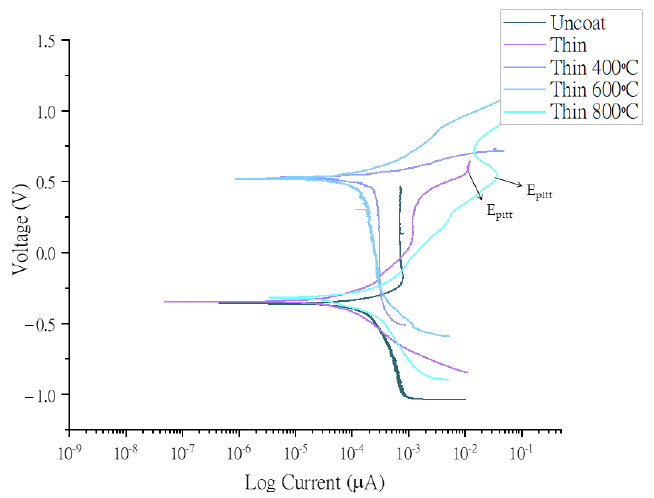
Figure 5. Polarization curves of Co30Cr20Ni20Mo20Ti10 alloy versus Ag/AgCl electrode in Hank’s solution. Working electrode was deposited at 2 × 105 ion density (thin coat) without heat treatment and with heat treatment at 400 °C, 600 °C, and 800 °C.